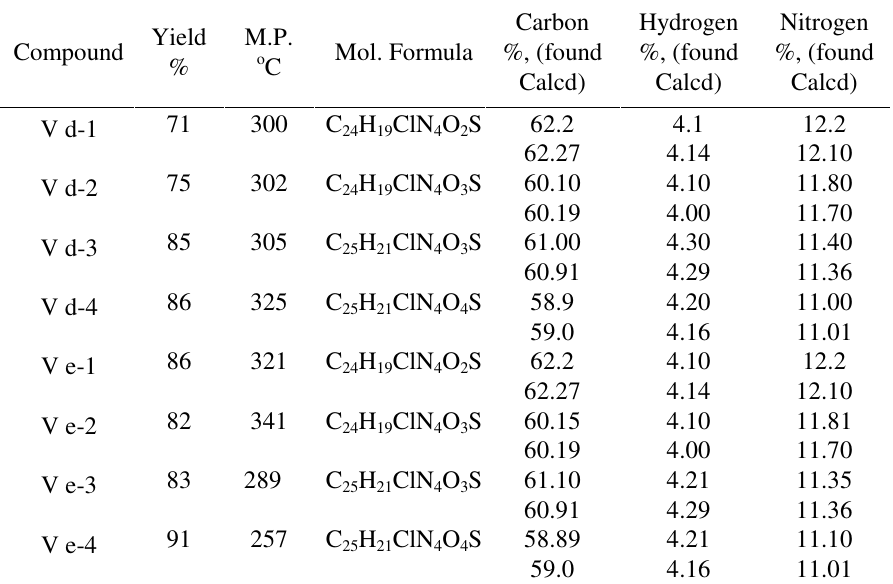
Table 8. General characteristics and elemental analysis data of the compounds V (d,e)(1-4)